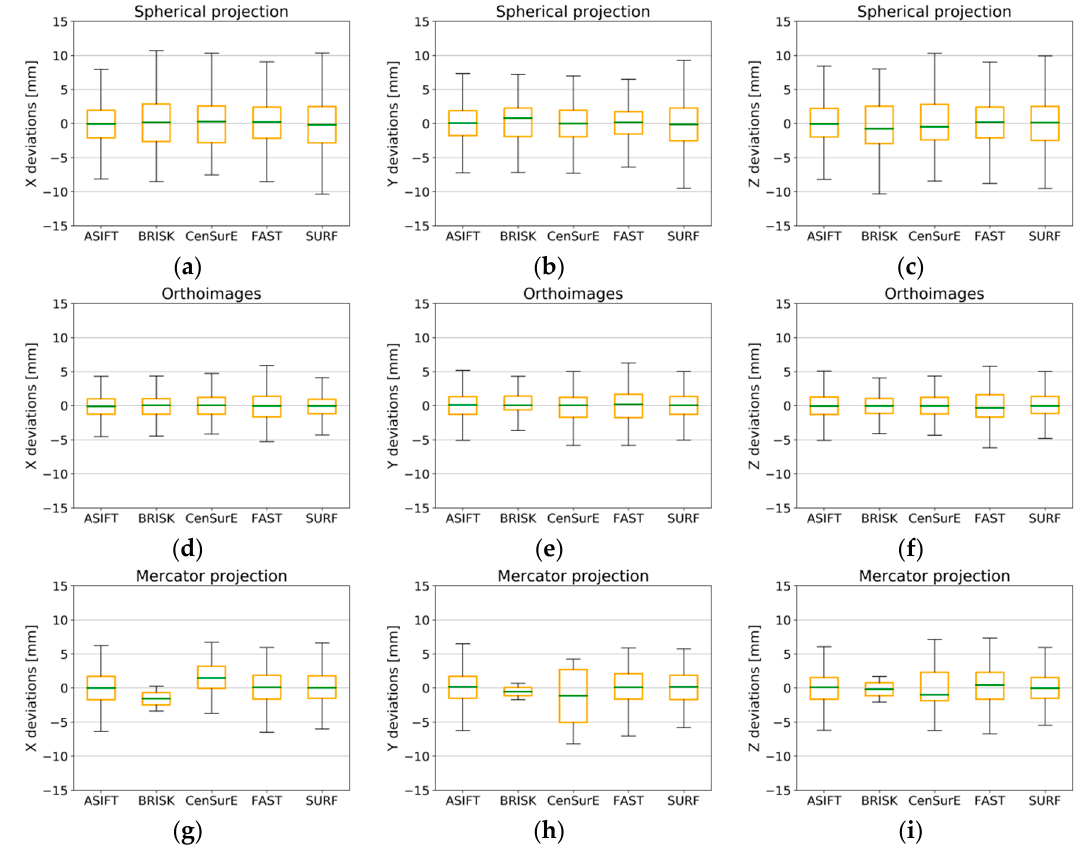
Figure 19. Box plots for the distribution of the deviations of natural check points for all pairs of fully registered scans (without points used for the ICP and non-registration) for Test Site I. The spherical projection: component—x ( a ), y ( b ), and z ( c ); orthoimages: component—x ( d ), y ( e ), and z ( f ); the Mercator projection: component—x ( g ), y ( h ), and z ( i ).